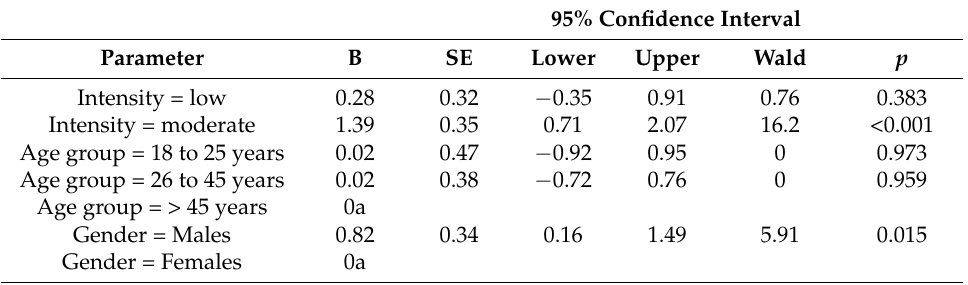
Table 5. Predictors of physical